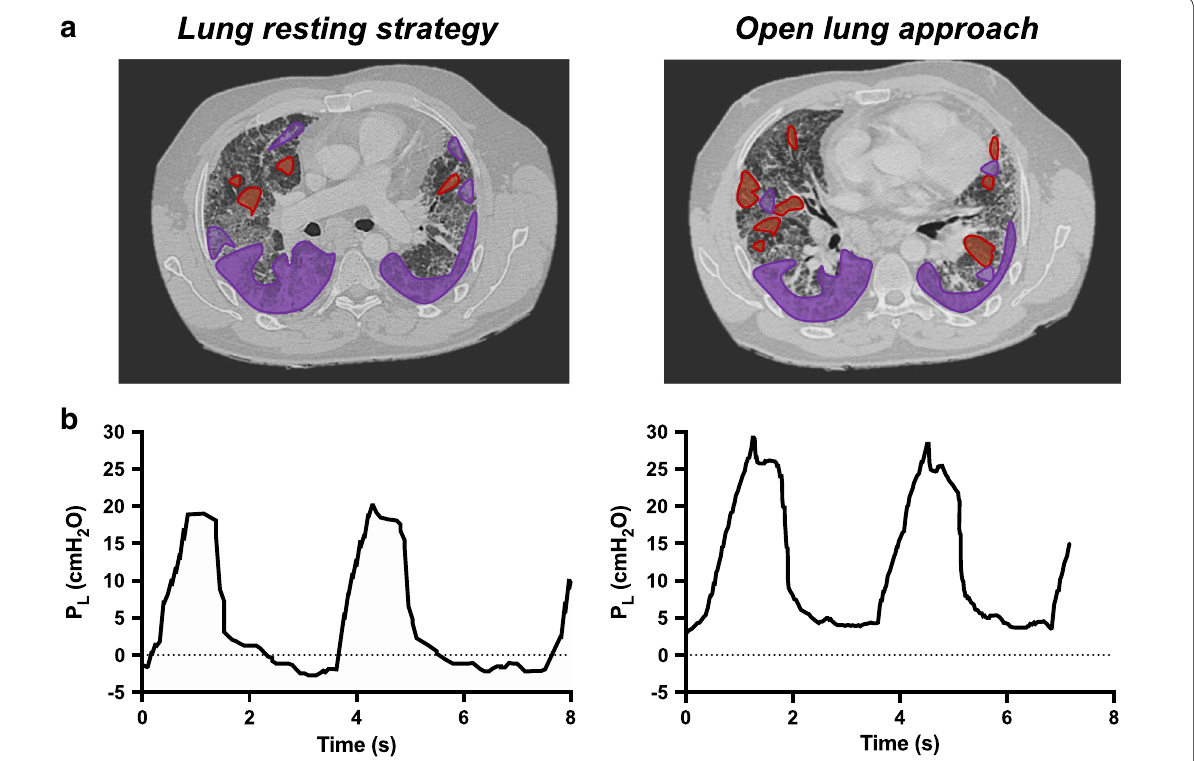
Fig. 3 CT scan images and transpulmonary pressure monitoring of a representative patient with UIP pattern and superimposed ground-glass during an AE-ILD, with PEEP set according to a “lung resting strategy” (left, PEEP 4 cmH 2 O) or with an “open lung approach” titrated to achieve positive end-expiratory transpulmonary pressure (right, PEEP 12 cmH 2 O). End-inspiratory transpulmonary pressure values significantly rise when higher values of PEEP are applied. Purple areas represent lung collapse, opacities and fibrous regions. Red circles highlight areas of over-inflation. AE acute exacerbation, ILD interstitial lung disease, UIP usual interstitial pneumonia, PEEP positive end-expiratory